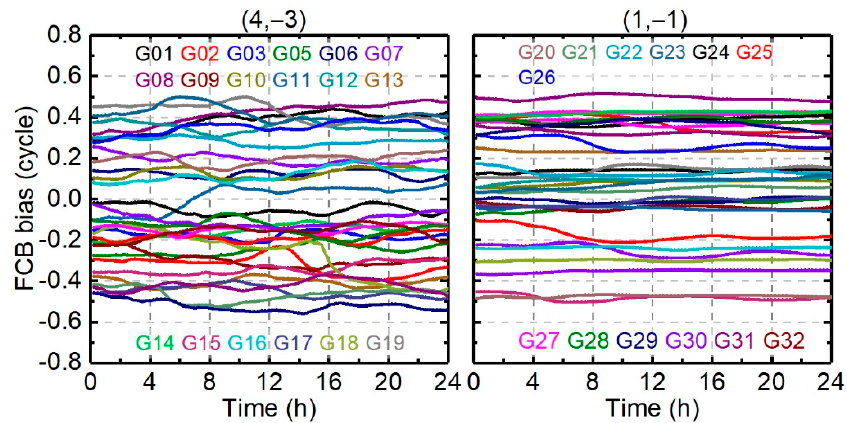
Figure 8. One day (3 September 2019) GPS FCB time series of the narrow-lane (NL) and wide-lane (WL) combinations.